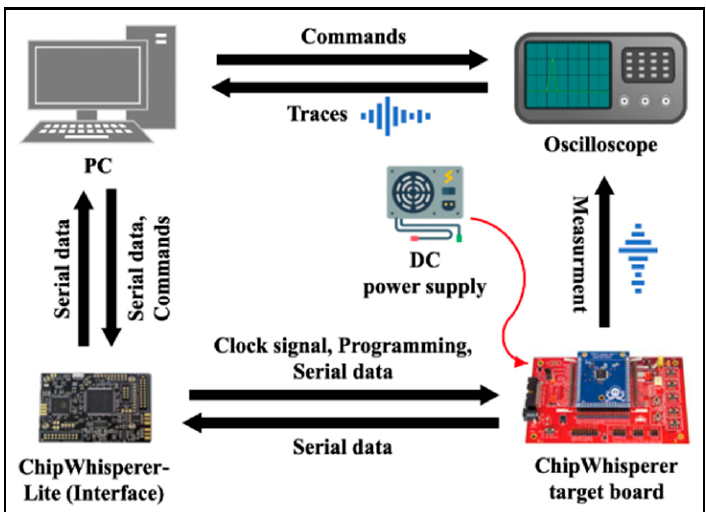
Figure 6. Instruction template acquisition structure using an oscilloscope and ChipWhisperer platforms. Table 2. The number of measured power consumption traces according to the microcontroller.